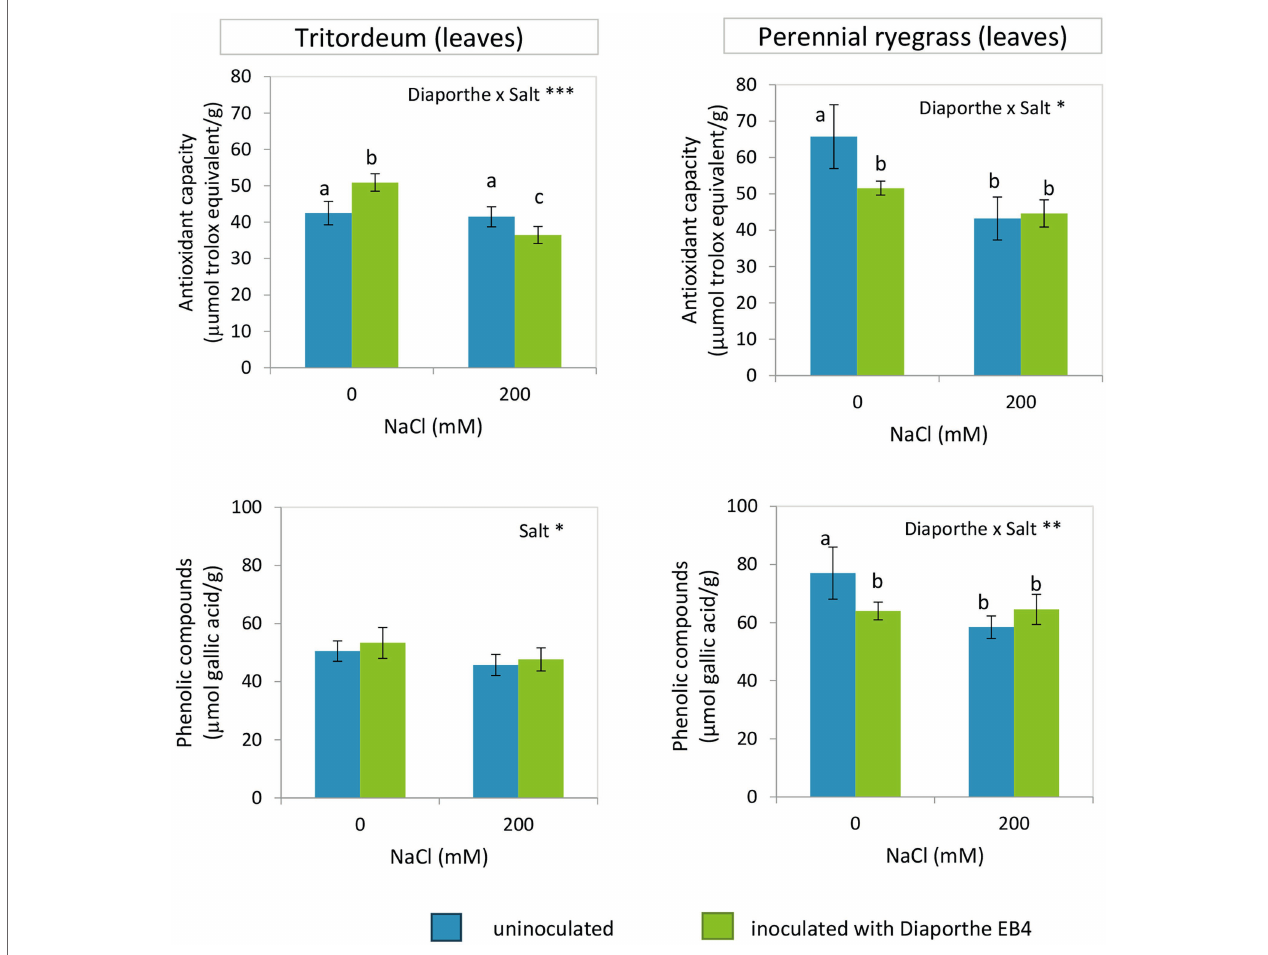
FIGURE 6 | Antioxidant capacity and phenolic compounds content in leaves of tritordeum and perennial ryegrass plants not inoculated ( BLUE ) or inoculated with Diaporthe EB4 ( GREEN ), at two different salinity treatments (0 and 200 mM NaCl). Values are means ± SD ( n = 6). When the interaction [ Diaporthe inoculation × salinity] was significant, different means are indicated with different letters (Tukey test p < 0.05). Significant effects of “ Diaporthe inoculation” and/or “salinity” are indicated